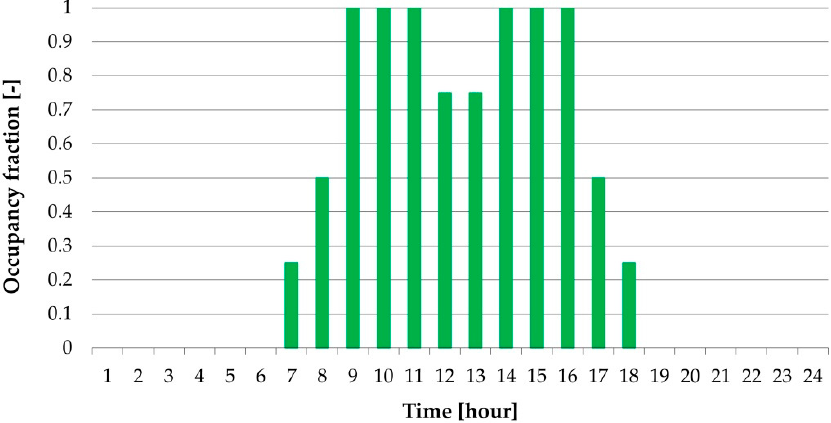
Figure 4. Occupancy presence schedule on working weekdays (where occupancy fraction is the fraction of the maximum possible occupancy density).